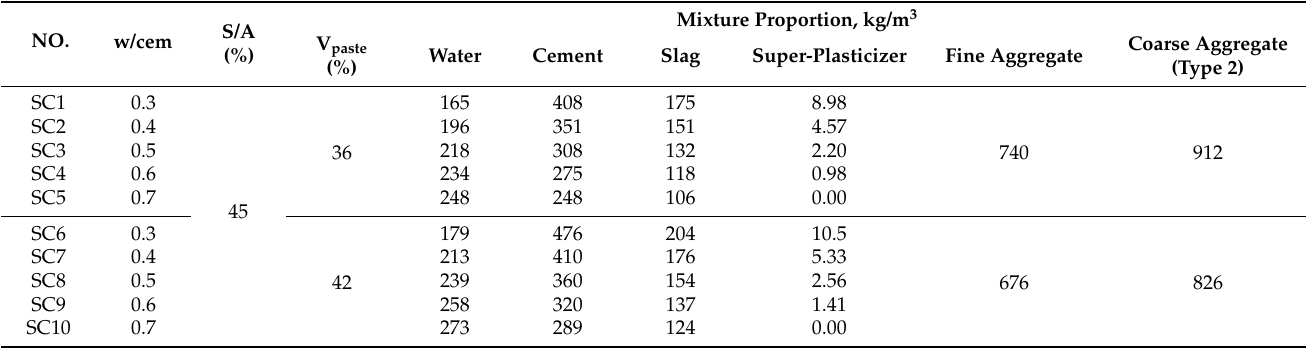
Table 4. Mixture proportions of various levels of slag concrete paste